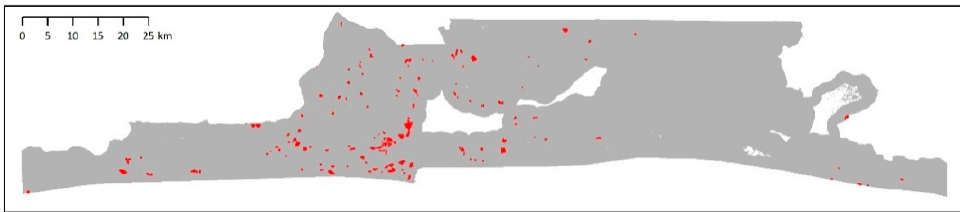
Figure 3. Lagos State (Nigeria) slum layer used to compare gridded population estimates of SDG 11.1.1 (printed with permission from Badmos and team (2019)). Red = slum, grey = non-slum or unsettled.